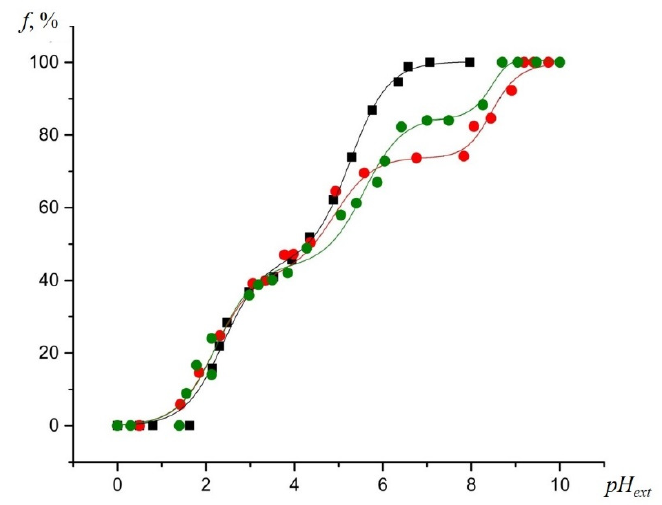
Figure 5. Experimental EPR titration curves for the NR at 293 K obtained by plotting the fast- and slow-motioned component of the EPR spectra of the NR in the non-protonated form ( f ) vs. pH ext in aqueous solution ( black squares ) and inside the SiO 2 (red circles), SiO 2 annealed at 850 °C ( green circles), respectively.